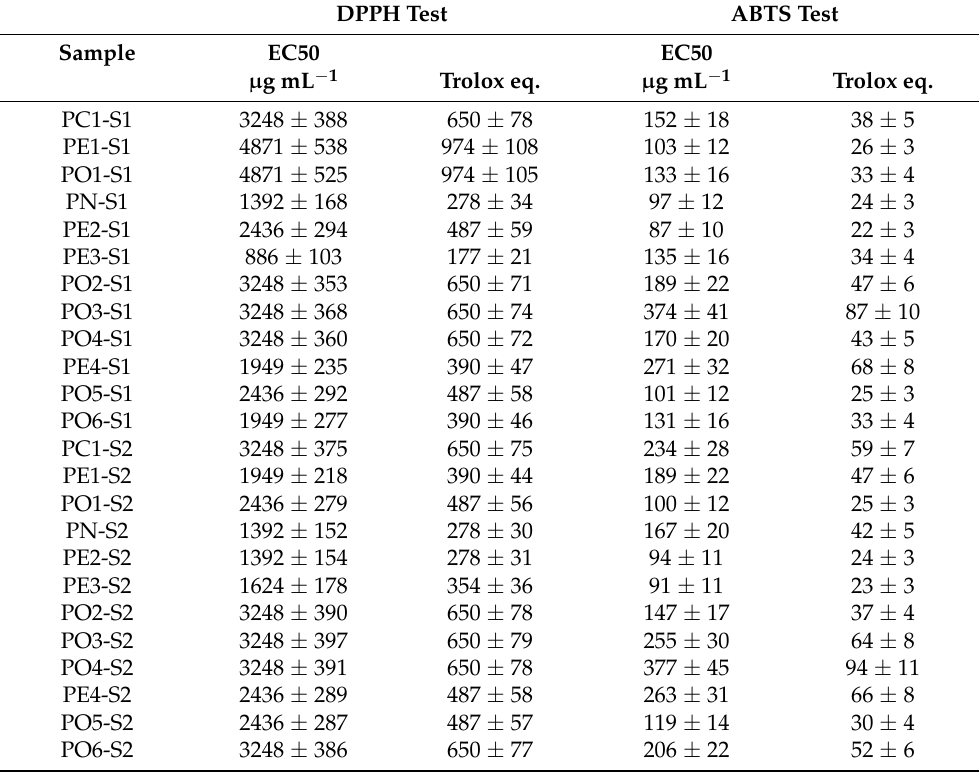
Table 12. Antiradical properties of the tested Pleurotus